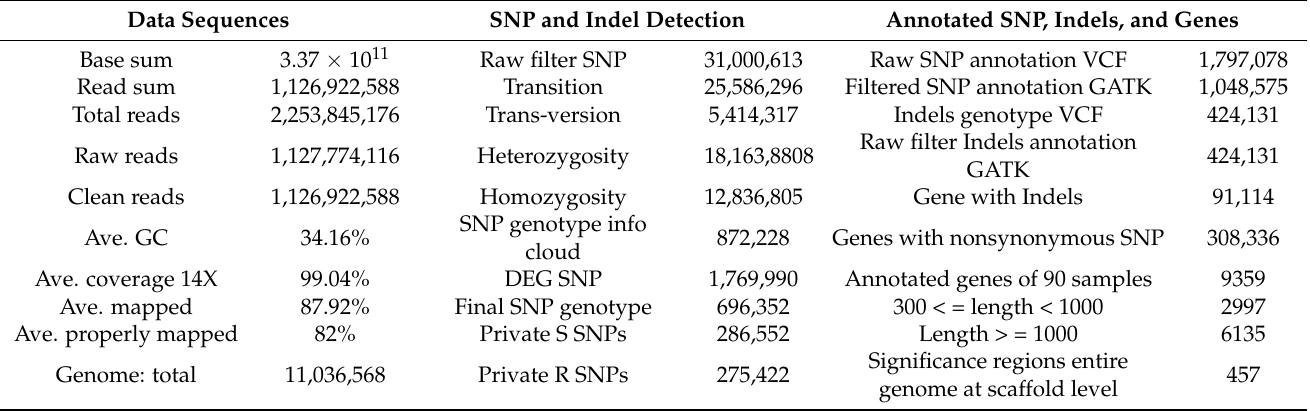
Table 1. An overview of the sequenced data, identified SNPs, indels, and annotations of 90 samples in A. c. cerana